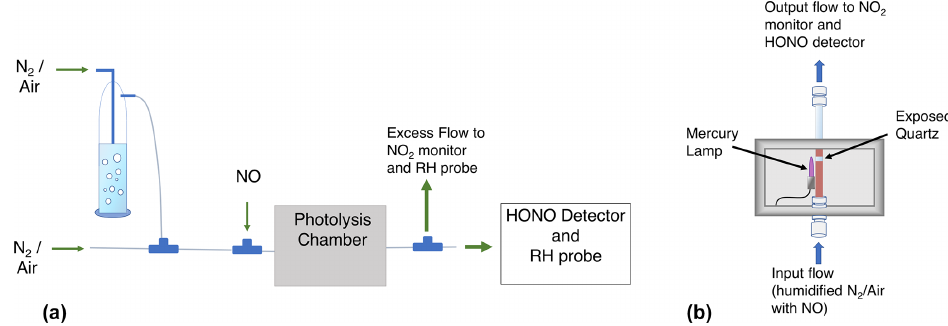
Figure 1. Schematic of the experimental setup (a) and the photolysis chamber (b) . Not shown: small flow of air when using N 2 as the carrier gas (a) and the purge flow of N 2 (b)